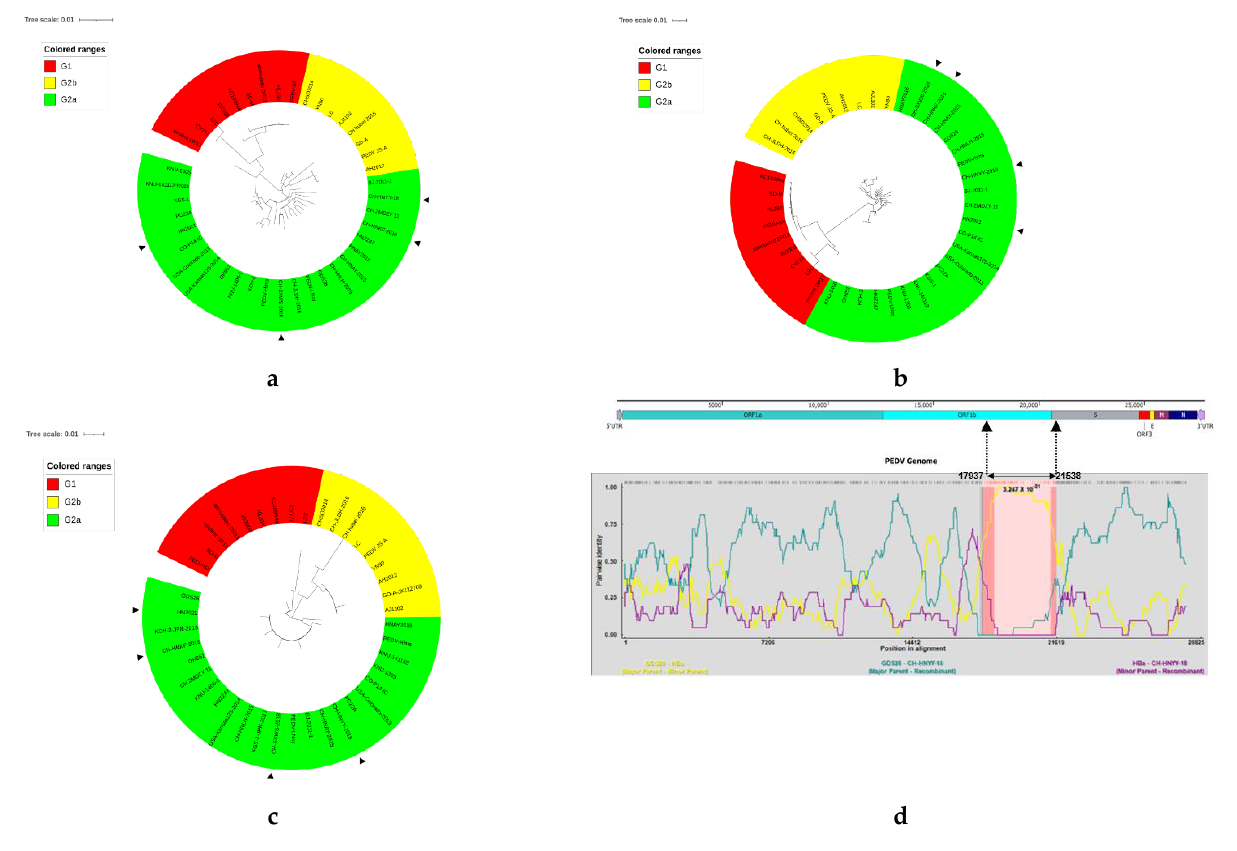
Figure 3. Genotyping and recombination analysis of the 41 PEDV strains in the present study based on different genes. Phylogenetic trees were constructed based on the aligned full-length genomic sequences ( a ), S gene ( b ) and ORF3 gene ( c ) by using the neighbor-joining method from MEGA 7.0, with 1000 bootstrap replicates. The trees were drawn to scale, with branch lengths measured in the number of substitutions per site. Group 1, G2a subgroup and G2b subgroup are colored in red, green and yellow, respectively. The triangle symbols represent the strains obtained in this study. ( d ) Recombination analysis of CH-HNYY-2018 with indicated PEDV strains. The result was described using the RDP method which was supported by >6 programs to further characterize the potential recombination events. The black arrow indicates the regions where a recombination event may